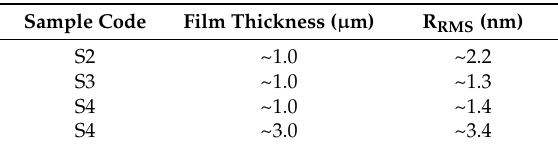
Table 2. Root mean square roughness (R RMS ) values inferred from the AFM measurements performed on 2 µ m × 2 µ m microscopic fields for AlN films deposited under different working